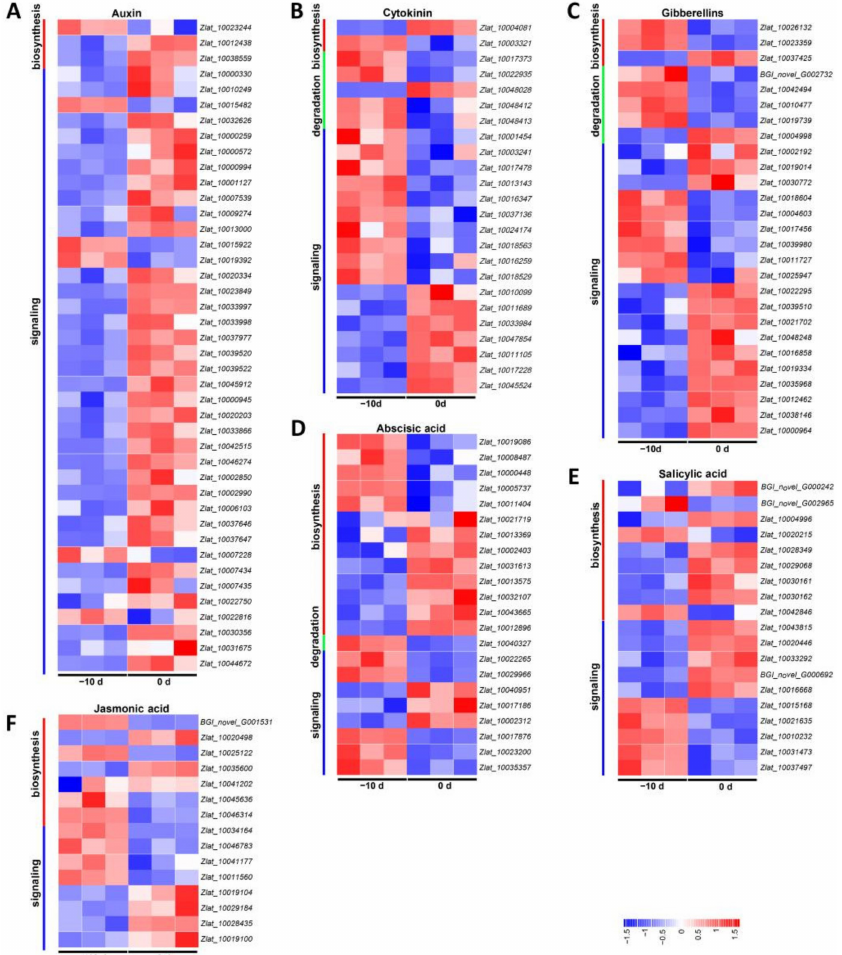
Figure 6. Expression profiles of DEGs related to hormone metabolism and signals between the two stages ( − 10 d and 0 d) of stem-gall formation based on the Z. latifolia genome in RNA-Seq. ( A – F ) DEGs for auxin, cytokinin, gibberellin, abscisic acid, salicylic acid and jasmonic acid. Red, green and blue lines represent biosynthetic degradation and signal transduction DEGs,